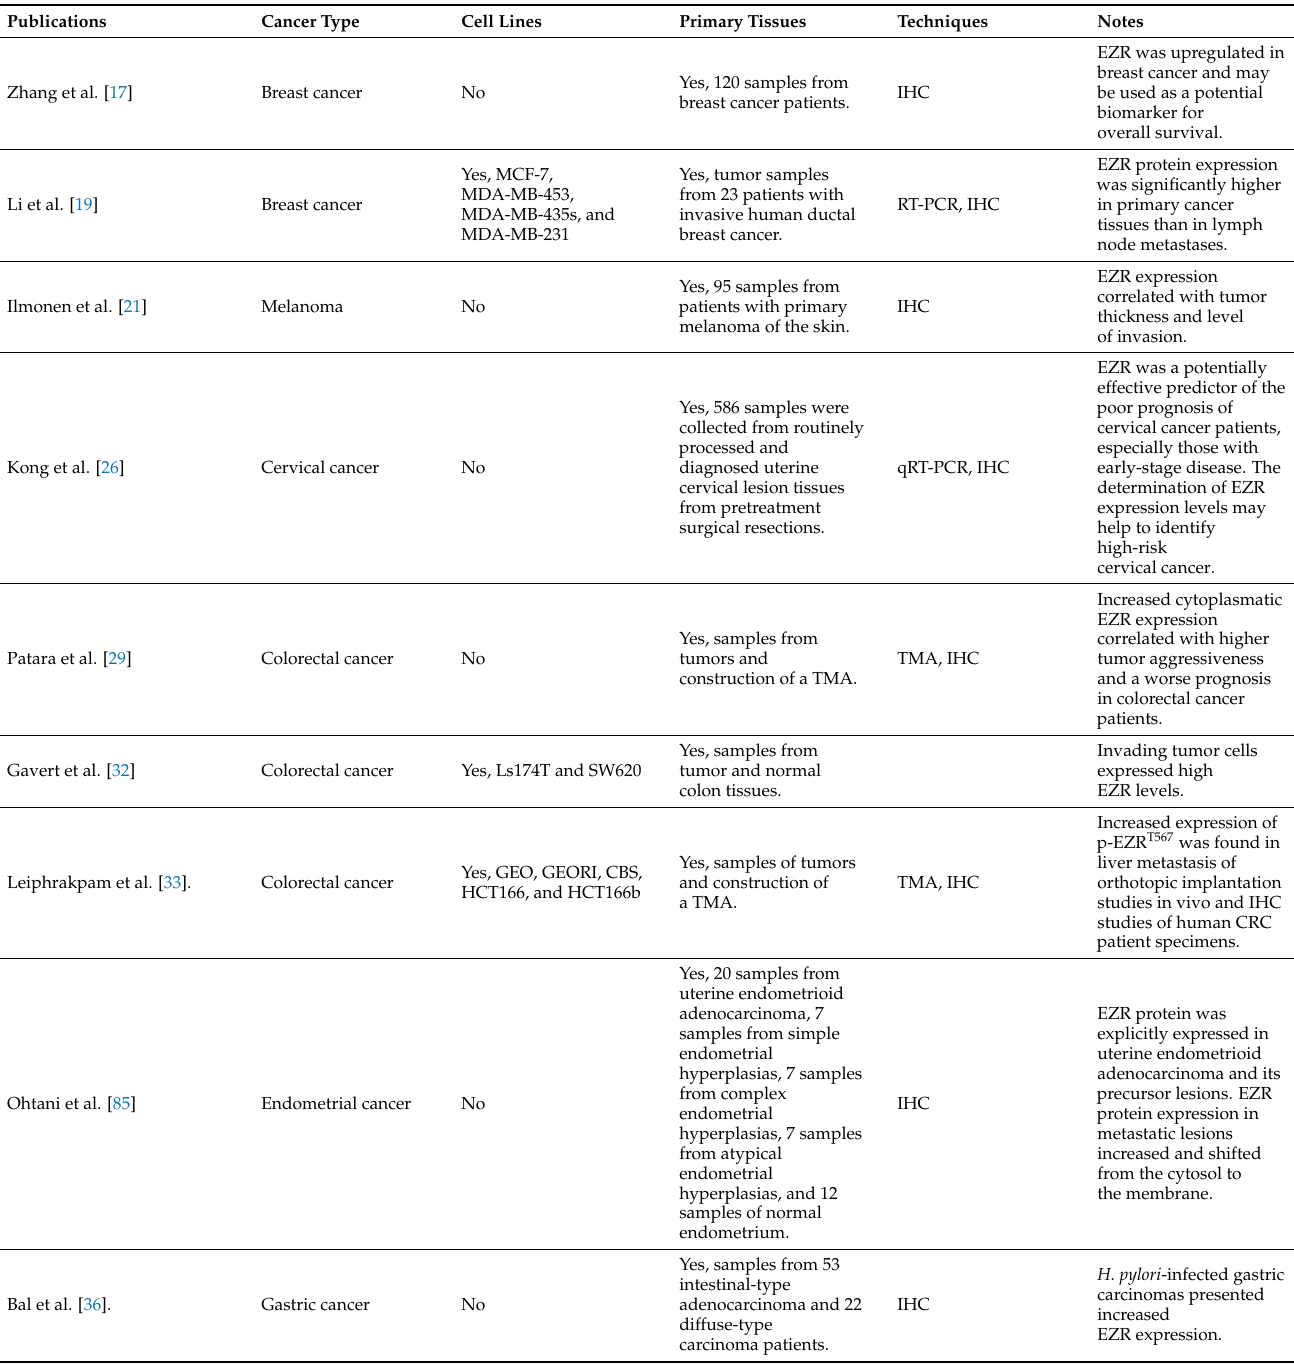
Table 1. Summary of EZR expression in